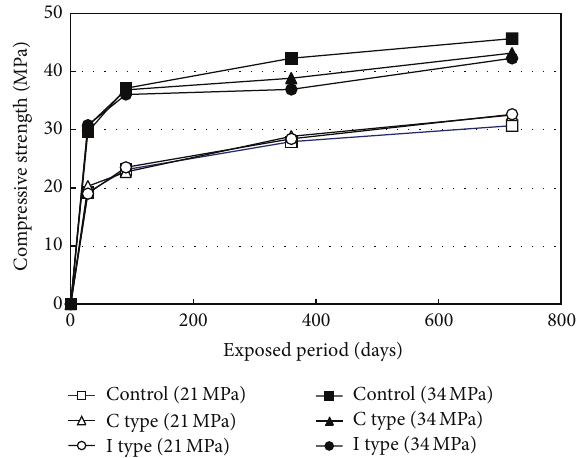
Figure 5: Change in compressive strength in surface-impregnated concrete under long-term exposure condition.